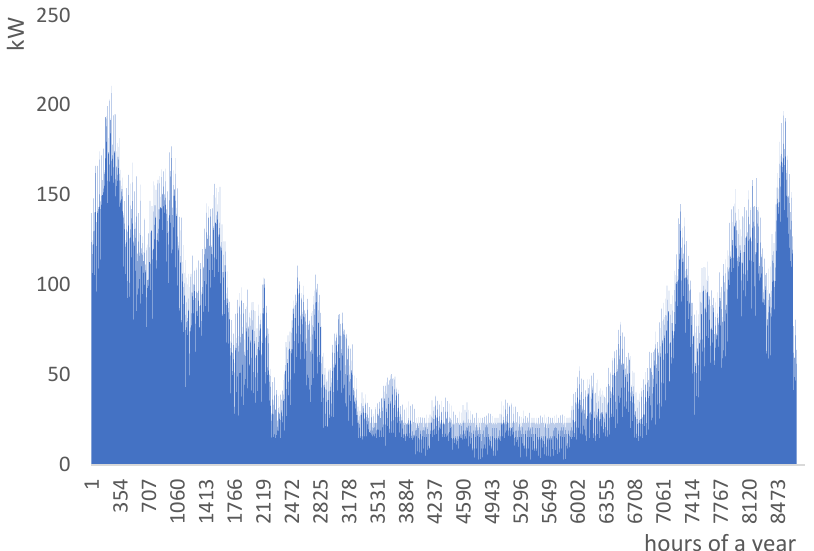
Figure 7. The average monthly heat demand of the group of buildings in a typical year.